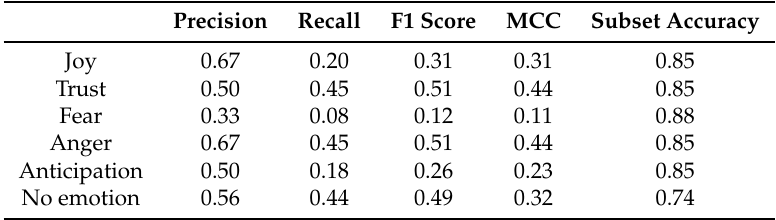
Table 9. Accuracy of fine-tuned settings in TF-IDF representation, Multi-nomial Naive Bayes classifier. Precision